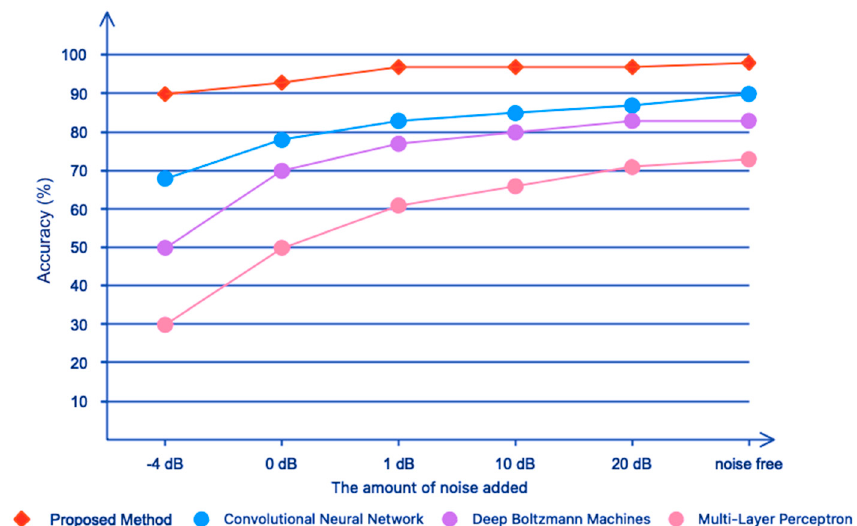
Figure 15. The test accuracy of the different methods based on feature learning for each SNR.